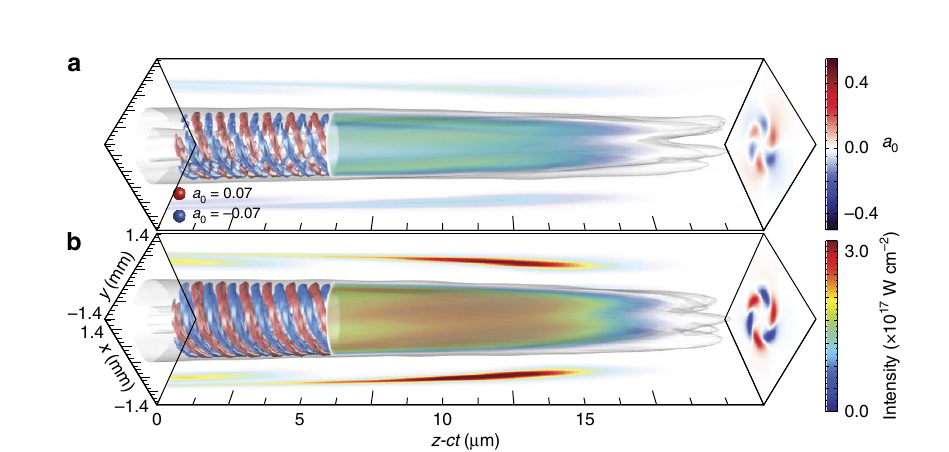
Simulation parameters are close to ideal Raman amplification regimes determined in ref. 21. In all simulations, the probe has a central wavelength of 1 m m. The background plasma density is n 0 ¼ 4.3 (cid:10) 10 18 cm (cid:2) 3 for all simulations presented. When the pump/probe initially has components in both the transverse directions, the initial peak a 0 , spot size and durations present in the table are identical forevery component. L ‘ n refers to a Laguerre–Gaussian ð n ;‘ Þ mode, wherethe OAM corresponds to the index ‘ . TEM mn correspond to Hermite–Gaussian lasers with order ( m , n ). Thetable only describes the initial simulation conditions.